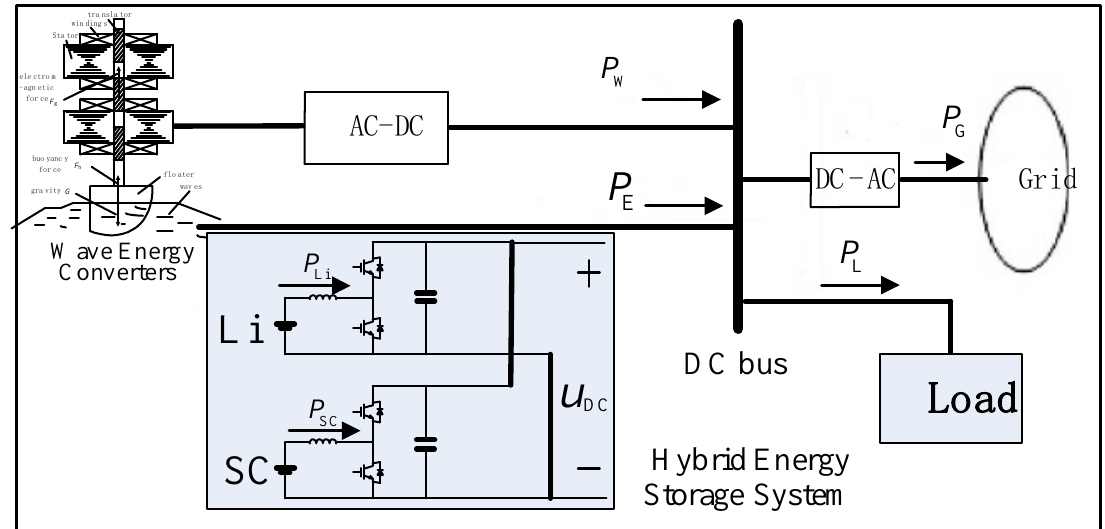
Figure 2. A linear wave converter and composite energy storage microsystem.